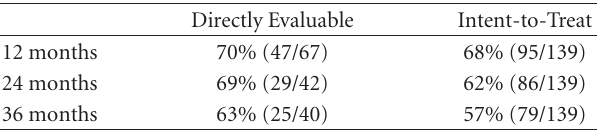
Table 9: 50% Reduction in pad Weight ∗ . Table 10: “Dry” Pad ( <